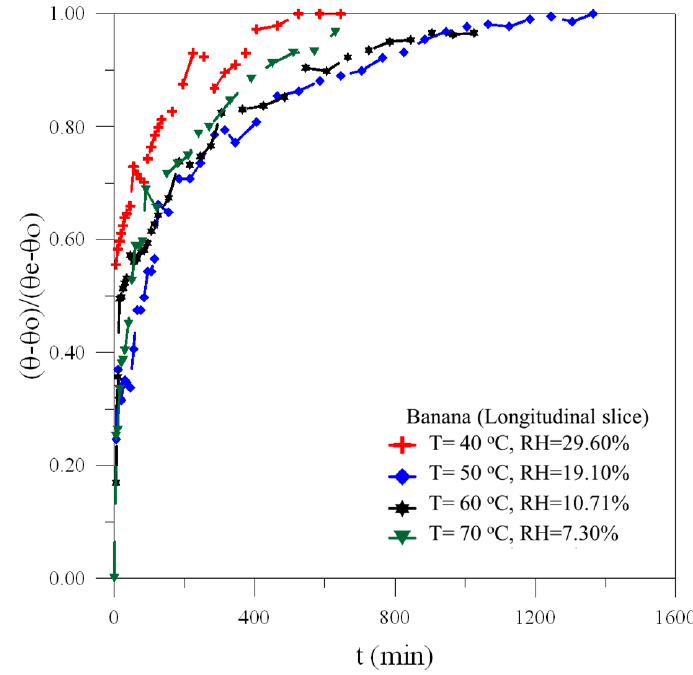
Figure 7. Dimensionless surface temperature of the longitudinal sliced banana as a function of the drying time.